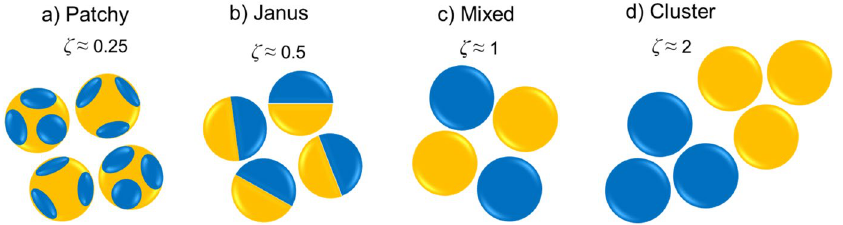
Figure 1. Sketch of four models for wettability heterogeneity. Wet- and non-wet surfaces are represented by blue and orange, respectively. All models have the same grain diameter and average surface energy but differ in the ζ (adapted from Murison/Hiller 7,47